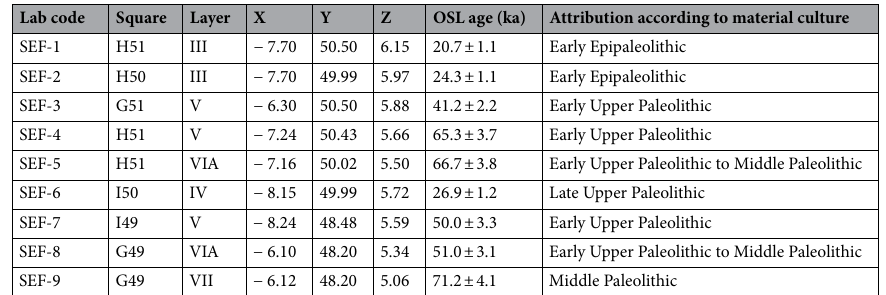
Table 1. Field data, OSL ages and cultural attribution for samples taken. Samples SEF-1 to SEF-3 are from 21